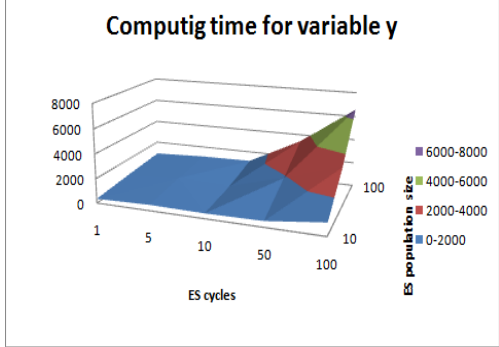
Fig. 7: Computing time of whole GPA-ES for y variable depending on ES cycle limit and ES population size.